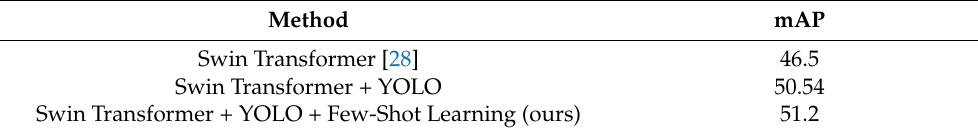
Table 1. The results of the performance evaluation for each method.